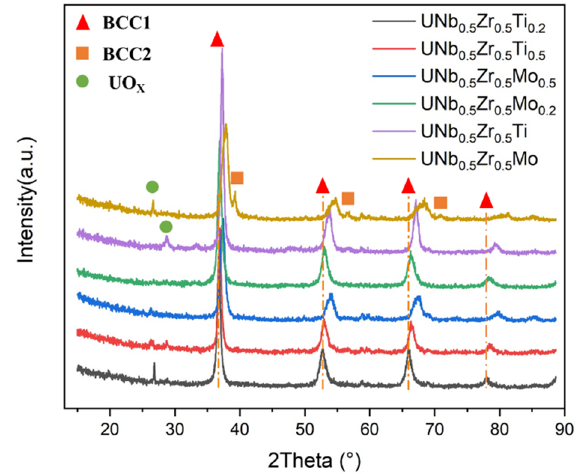
Figure 6. ( a ) δ - Δ H and ( b ) δ - Ω distribution diagram of UNb 0.5 Zr 0.5 -X HEAs. The XRD results of UNb 0.5 Zr 0.5 -X (Ti/Mo) HEAs presenting BCC structures are repre- sented in Figure 7. Ignoring the uranium oxides, most of the alloys consisted of a single BCC structure, UNb 0.5 Zr 0.5 Ti and UNb 0.5 Zr 0.5 Mo HEAs forming two BCC structures. The diffraction peak changed to a higher angle as the concentrations of Ti and Mo grew, show- ing that the lattice constant dropped [32]. As presented in Table 2, the lattice contents of U, Mo, and Ti at room temperature are 343.3 pm, 314.7 pm, and 327.6 pm [17,26], respec- tively. With the addition of Ti and Mo, the lattice constant of the matrix decreased, indi- cating the occurrence of solid solution and the generation of lattice distortion. When the content of Mo reached the maximum, UNb 0.5 Zr 0.5 Mo was composed of two BCC struc- tures, which was because Mo has the highest melting point of the elements.